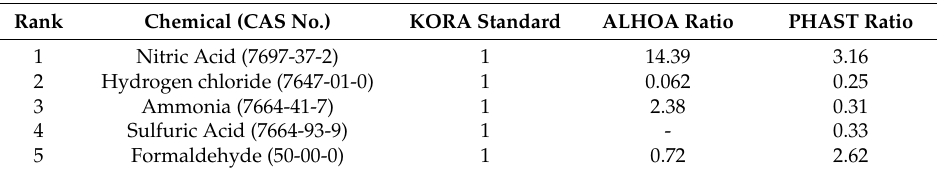
Table 10. Damage distance compared ratio based on KORA.